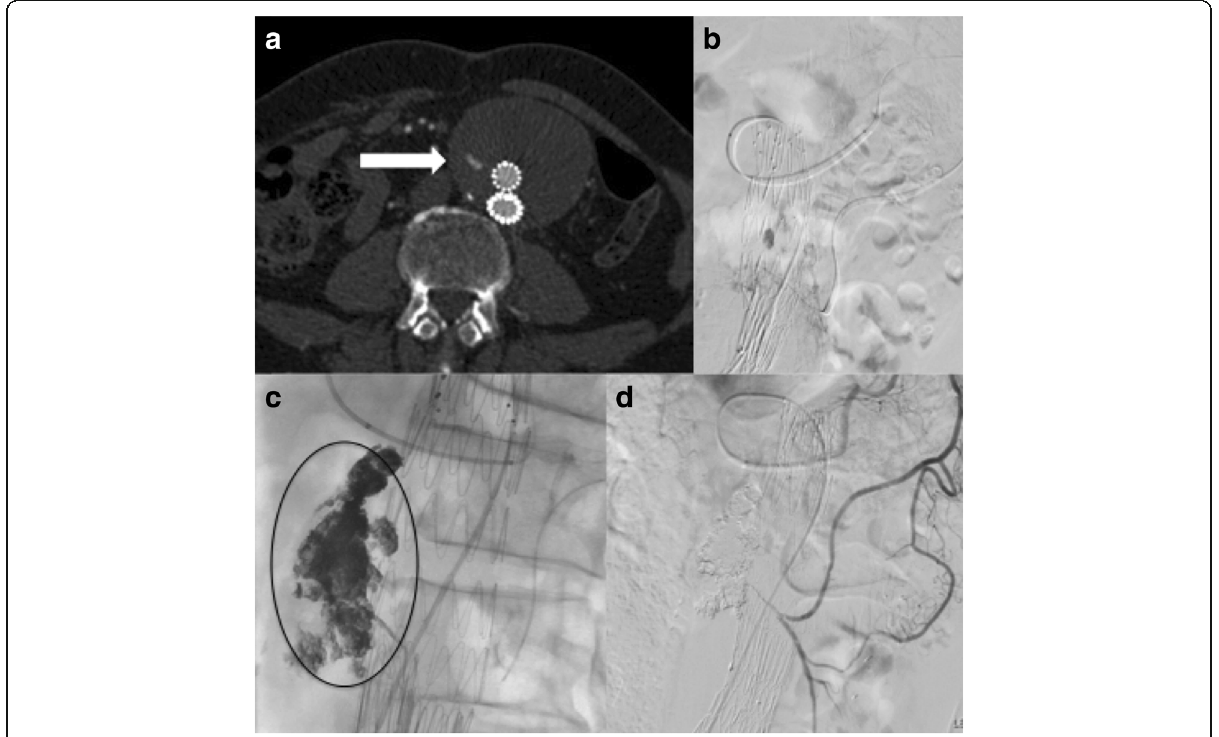
Fig. 4 Percutaneous embolisation for type II endoleak. a Delayed CTA reveals the presence a type II endoleak (arrow). b .Angiogram confirming the access via the Riolan arcade to the IMA. c Embolisation with Onyx and ( d ) satisfactory angiographic